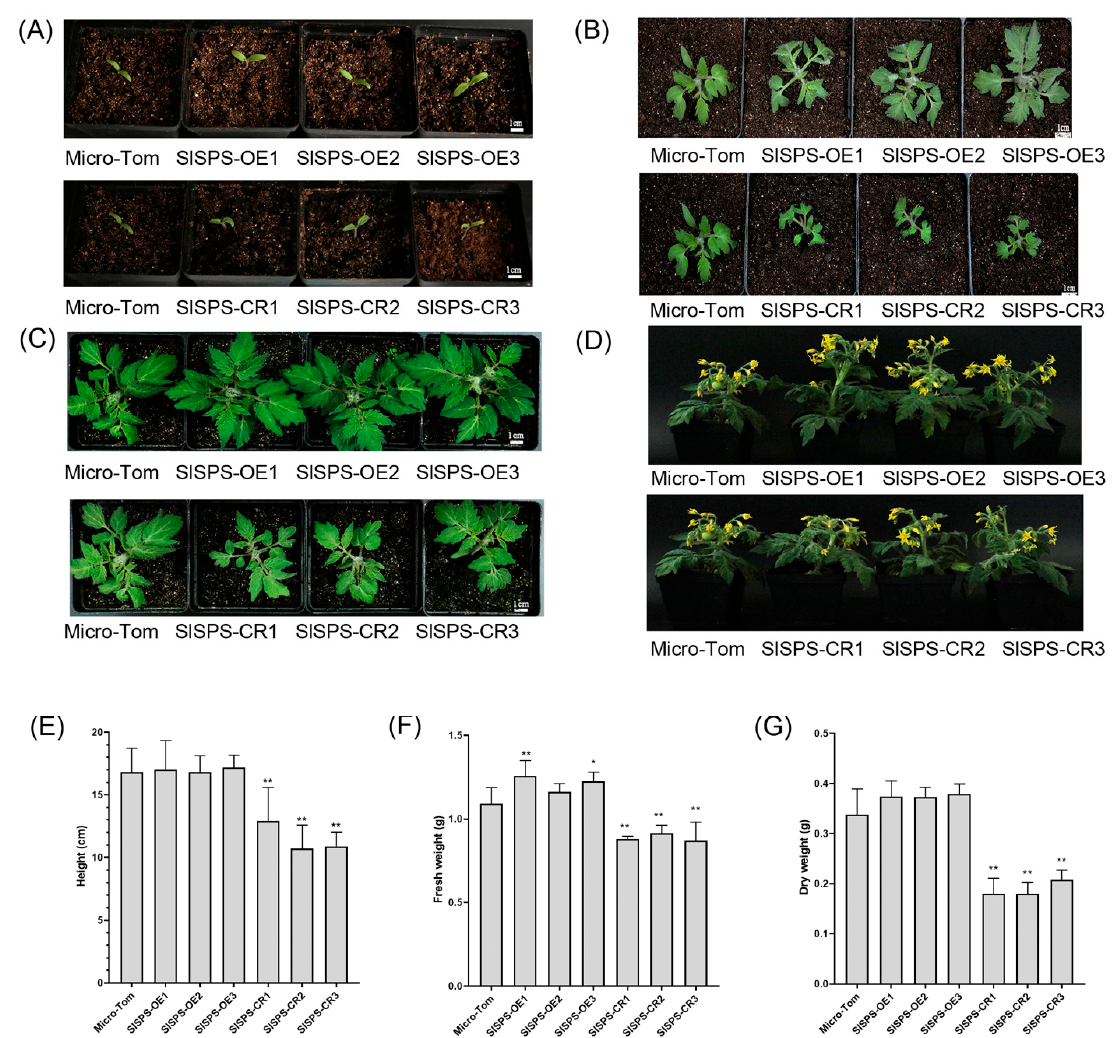
Figure 2. Phenotypes and biomass determination of transgenic lines (OE and CR) and Micro-Tom. Phenotypes of seedlings were observed at 2-week ( A ), 3-week ( B ), 4-week ( C ) and flowering stage ( D ). Determination of plant height ( E ), fresh weight ( F ) and dry weight ( G ) were performed at four-week seedling stage (n = 20 for each line). Values in ( E – G ) are means ± SD. * p < 0.05, ** p < 0.01, comparisons with Micro-Tom plants using Student’s t -tests.